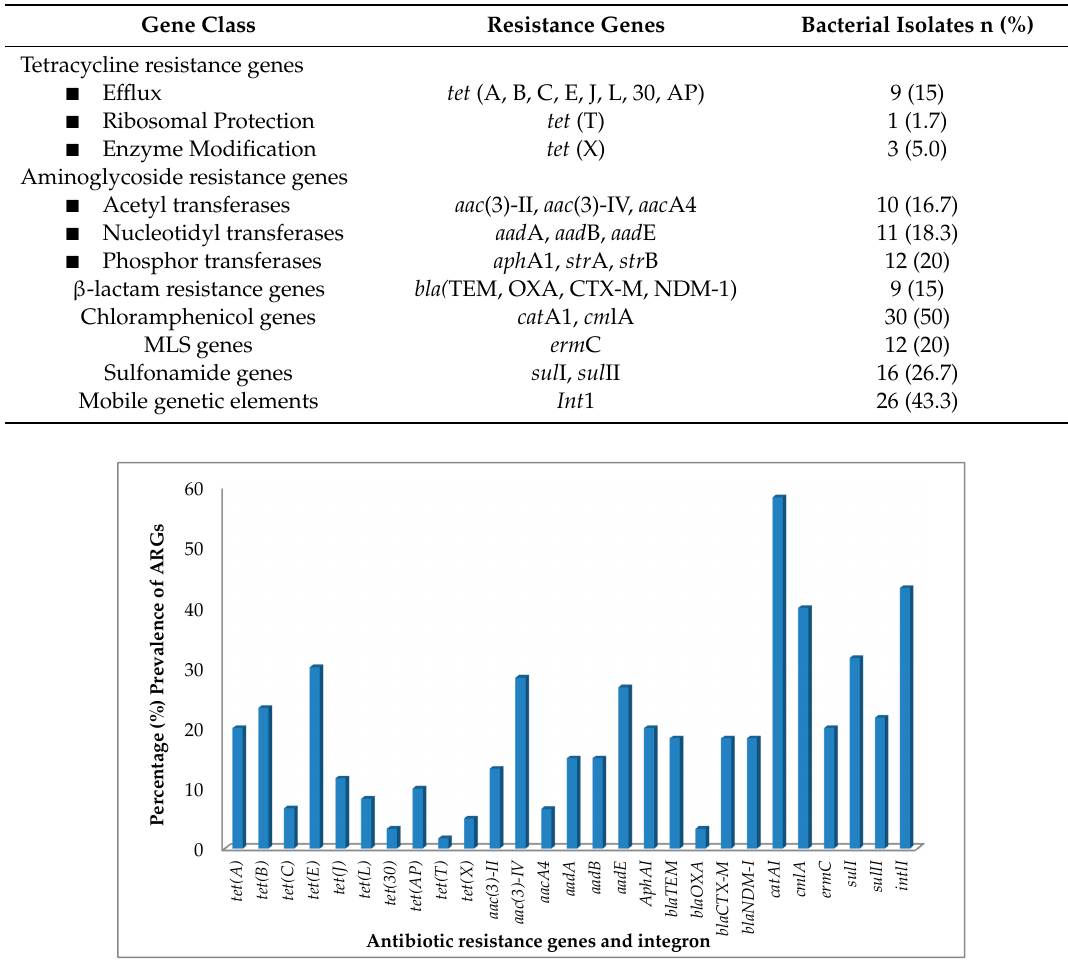
Figure 1. Percentage prevalence of antibiotic resistance genes (ARGs) and integrons from antibiotic-resistant bacteria (ARB) isolated from pharmaceutical wastewaters.